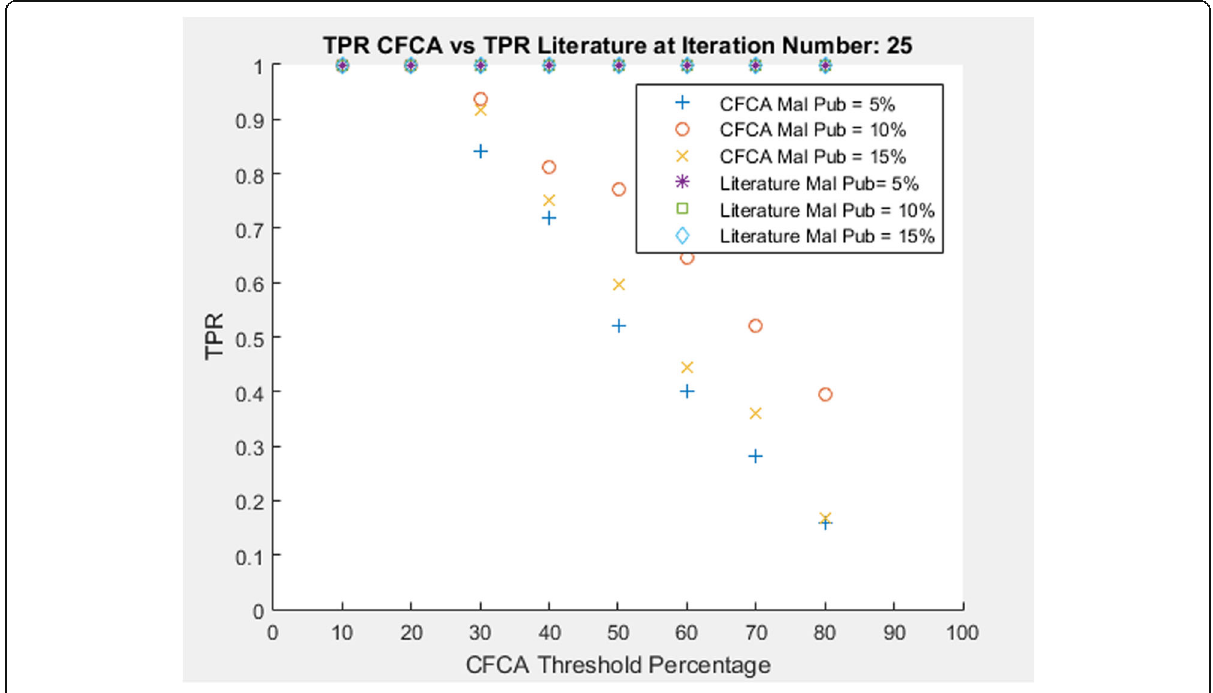
Fig. 6 TPR CFCA vs TPR literature at iteration I = 25